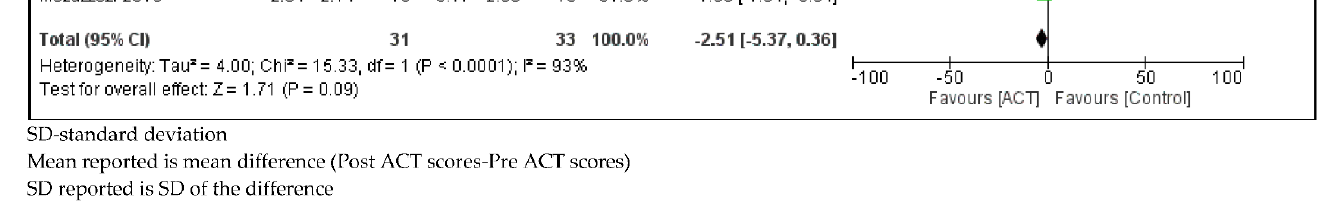
Figure 6. Forest plot comparing stress scores between children with SHCN who received ACT and children with SHCN who received no treatment.